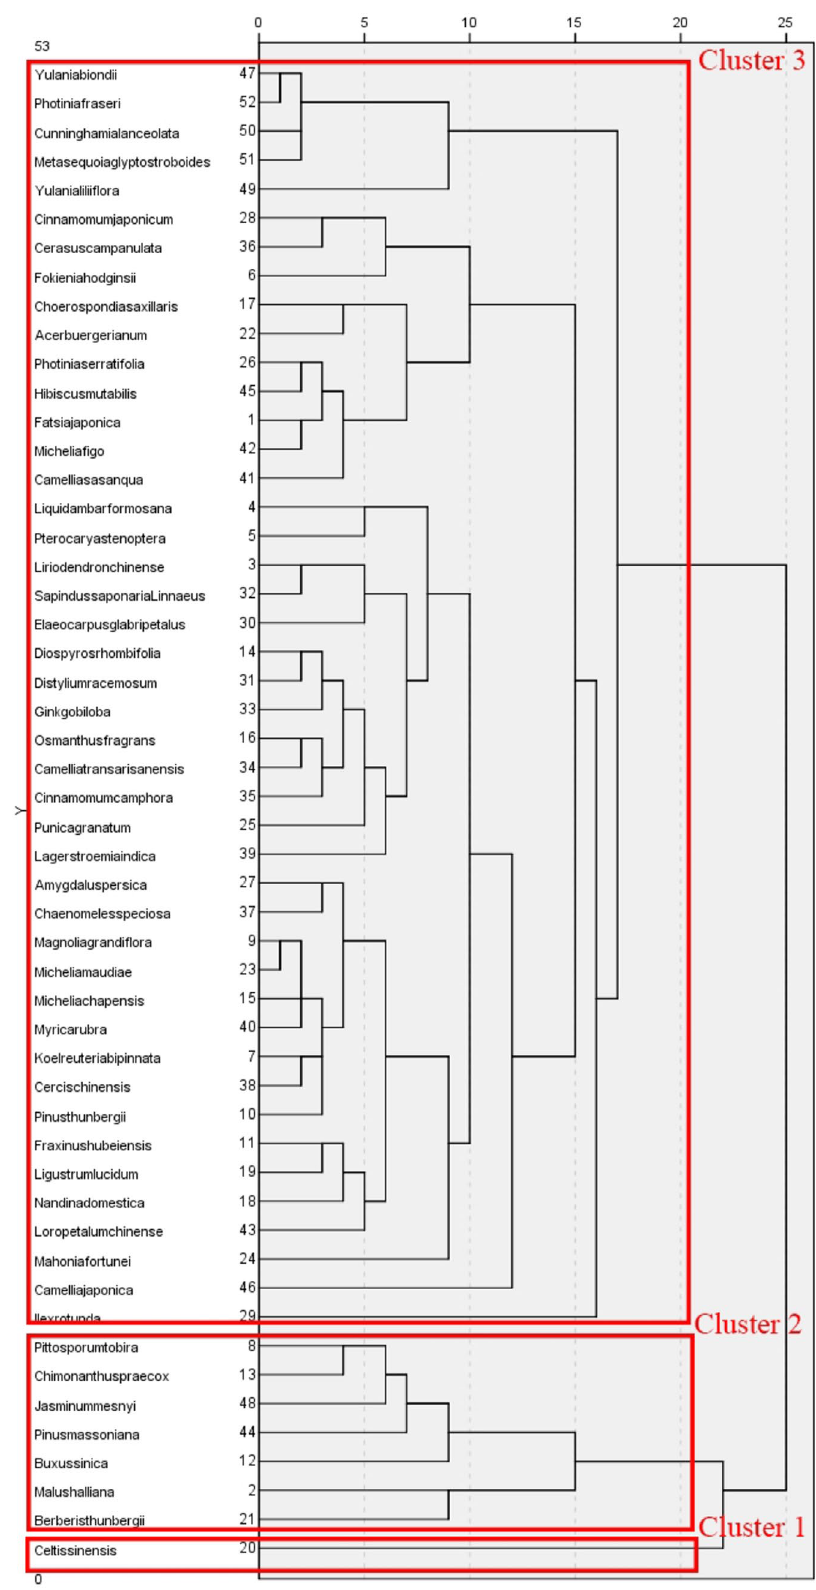
Figure 13. Clustering analysis of total duration of